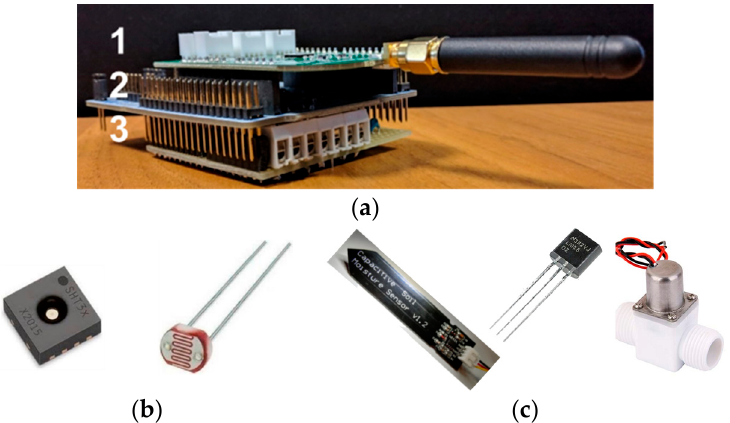
Figure 2. ( a ) Plant and Greenhouse node electronics and their actuator and sensors. (1) Semtech SX1272 LoRa Radio, (2) L152RE low power microcontroller, (3) Sensor/Actuator Interface Shield; ( b ) from left to right for the Greenhouse Node: Si7021 and Photoresistor. ( c ) from left to right for the Plant Node: “Capacitive Soil Moisture Sensor v1.2”, TMP36 or LM35 temperature sensor, and bistable solenoid valve.